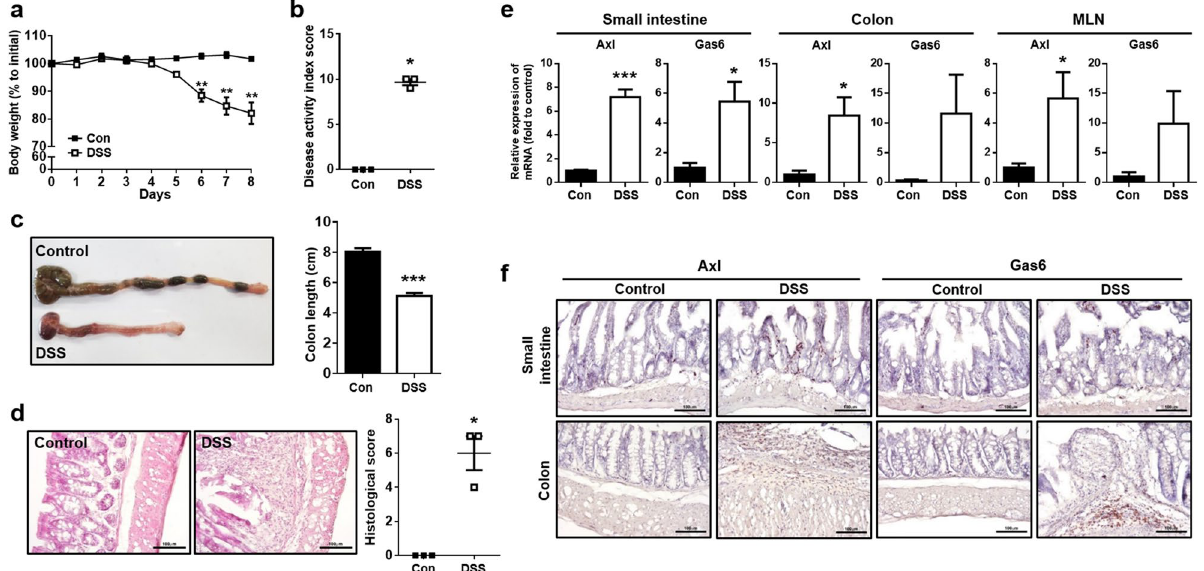
Figure 1. The expression of Axl was upregulated in DSS-induced colitis. ( a ) Changes in body weights were measured during the administration with 2.5% DSS for 8 days. Data are represented as a percentage of body weight relative to initial body weight. ( b ) DAI scores were evaluated based on body weight loss, stool consistency, and bleeding in the stool. ( c ) The macroscopic appearance of the colon (left panel) and the colon length (right panel) were measured on day 8 after DSS administration. ( d ) Representative microscopic images (magnification 200 ×) of colon tissues stained with H&E (left panel). The histological scores were evaluated according to the degrees of epithelial damage, edema, hyperplasia, and immune cell infiltration (right panel). ( e ) mRNA expression of Axl and Gas6 was analyzed by qRT-PCR in the small intestine, colon, and MLN. ( f ) The expression of Axl and Gas6 was evaluated by immunohistochemistry in the colon tissue. The brown-colored areas indicate the expression of Axl or Gas6. Data are shown as the mean ± SEM values. Significance (*p < 0.05, **p < 0.01, ***p < 0.001) was compared with control mice, calculated by the Student’s T-test ( a , c , e ) or Mann– Whitney test ( b , d ). Data are representatives of three independent experiments (n = 3 mice per group).